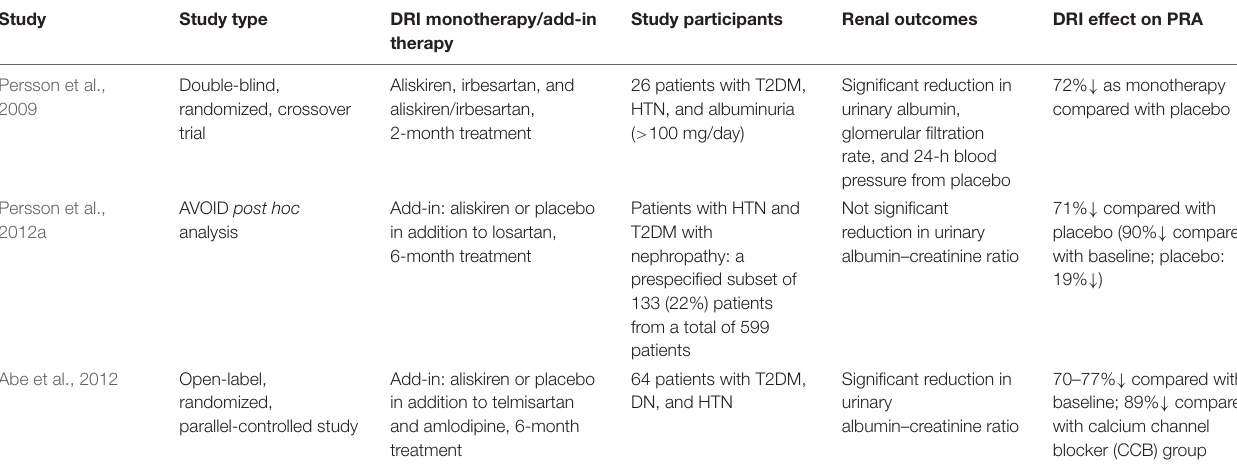
TABLE 1 | Clinical Studies with DRI in diabetic nephropathy that determined plasma renin activity.